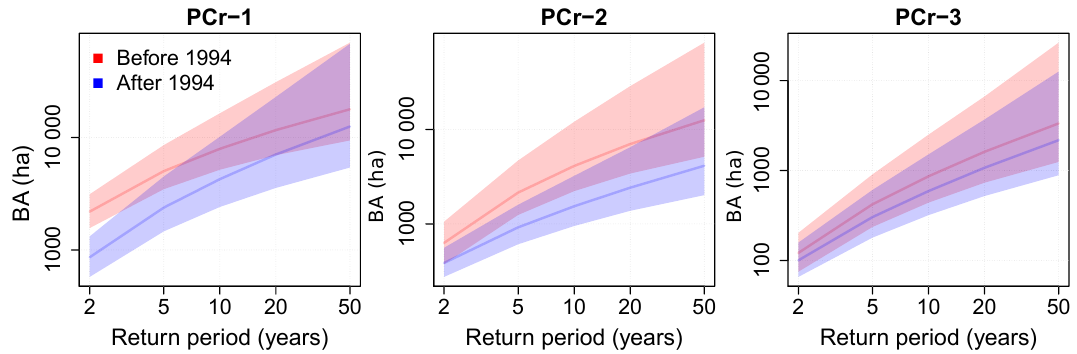
Figure 5. Comparison of return levels, before and after 1994, for each region. The 90% credible intervals are shown and median return levels are indicated in plain lines. BA (ha) is indicated on a log scale.